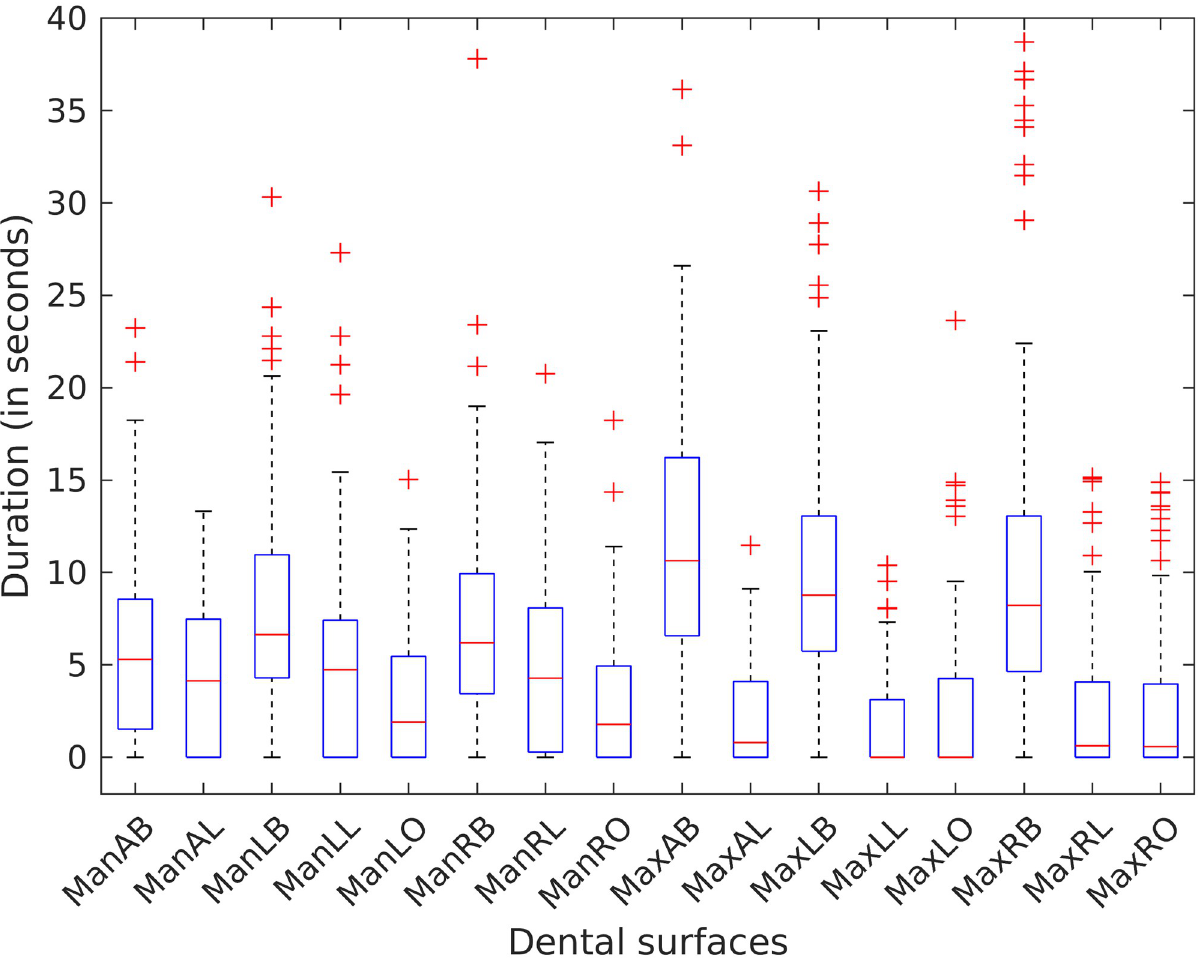
Fig 3. Group-level brushing time of all dental surfaces. MaxAB, MaxLB, and MaxRB were the areas brushed the longest and in contrast, MaxLL and MaxLO were frequently skipped during